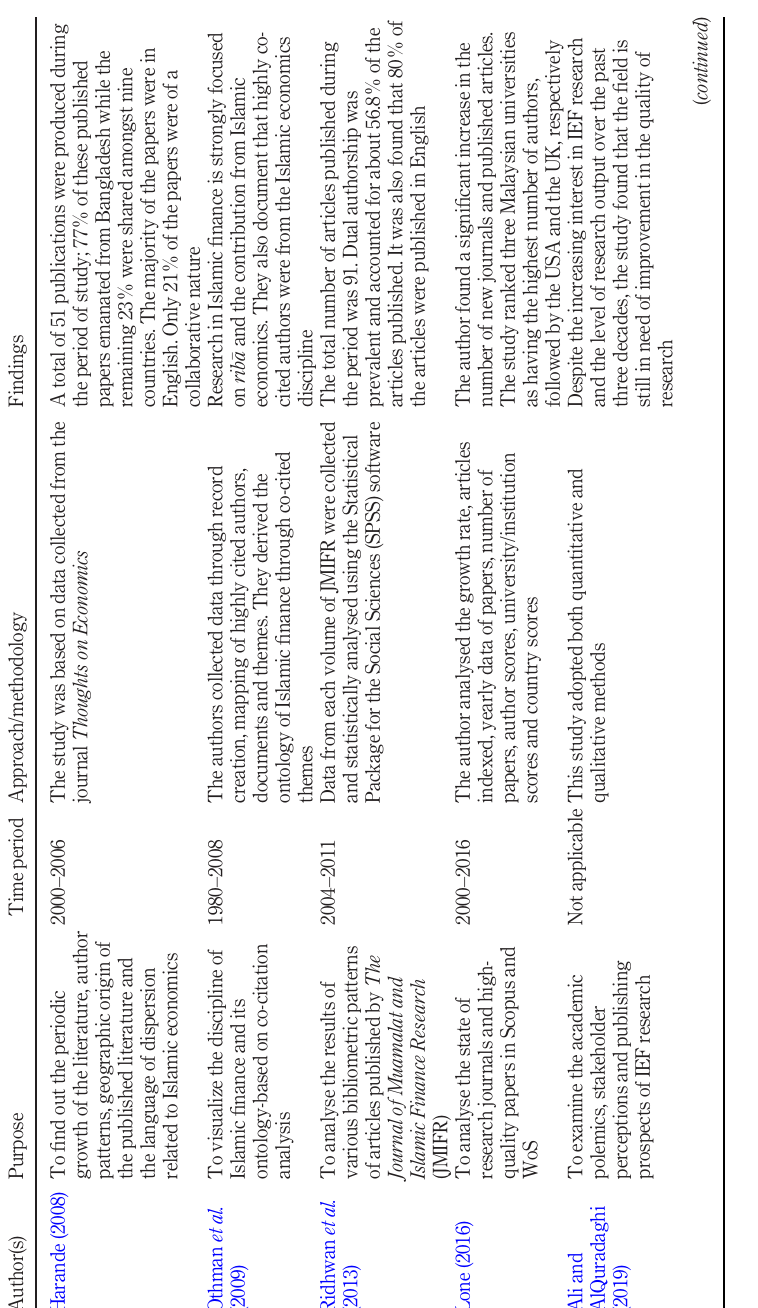
Table 1. Summary of